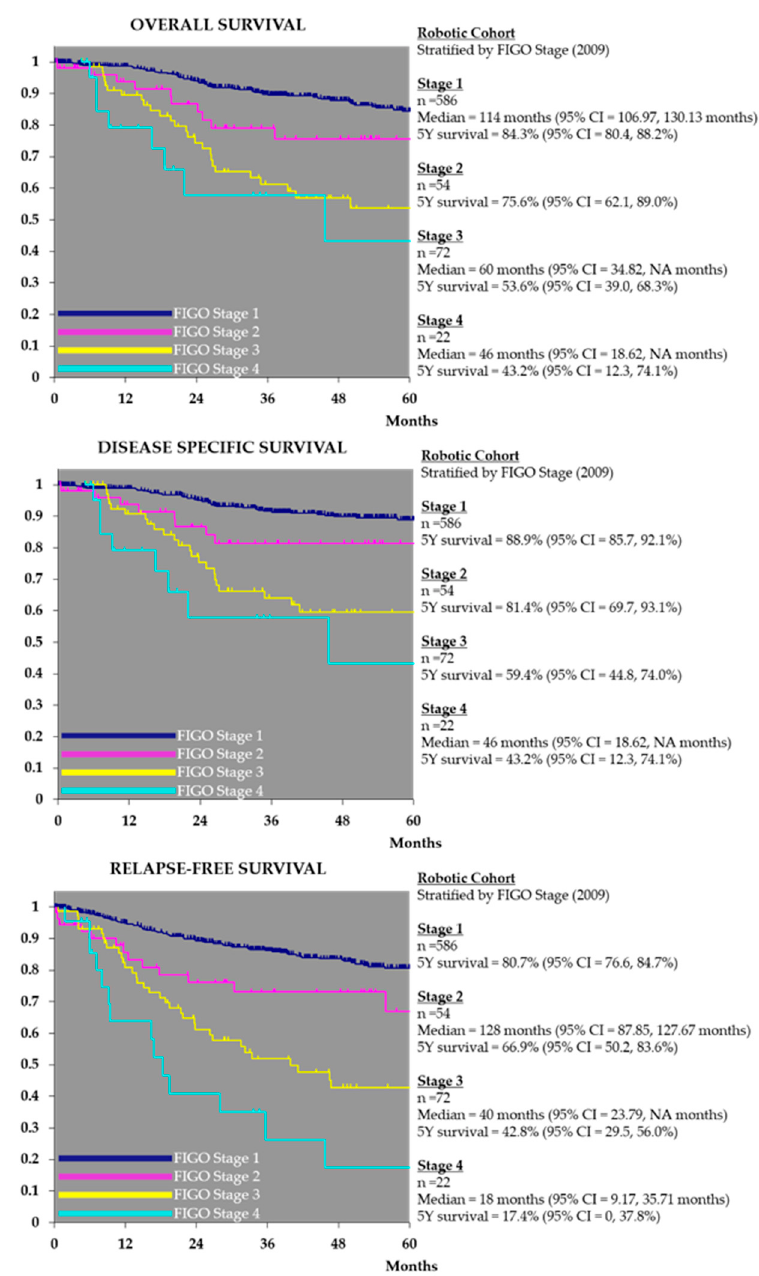
Figure 3. Robotic Cohort—Overall, Disease Specific Survival & Relapse Free Survival by FIGO Stage (2009).